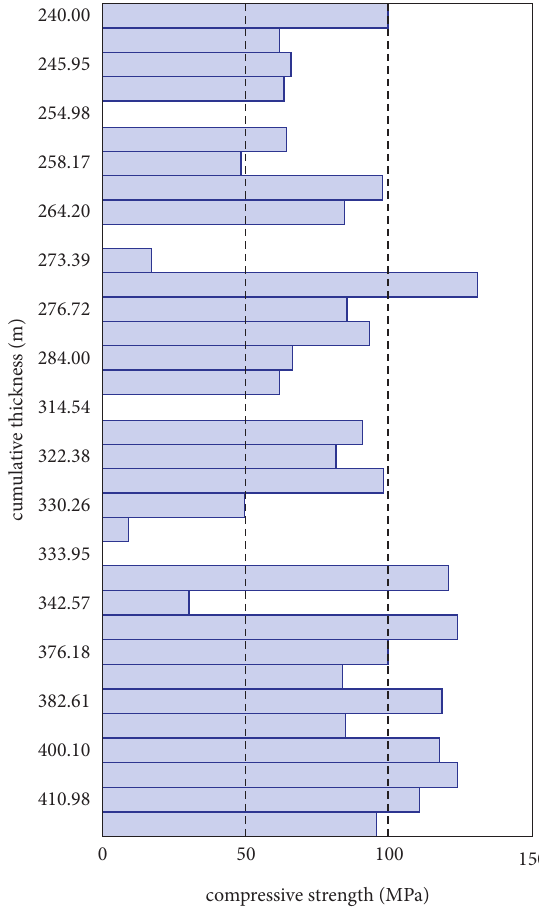
Figure 2: Statistical chart of the rock compressive strength of three-hole bedrock in T2191.